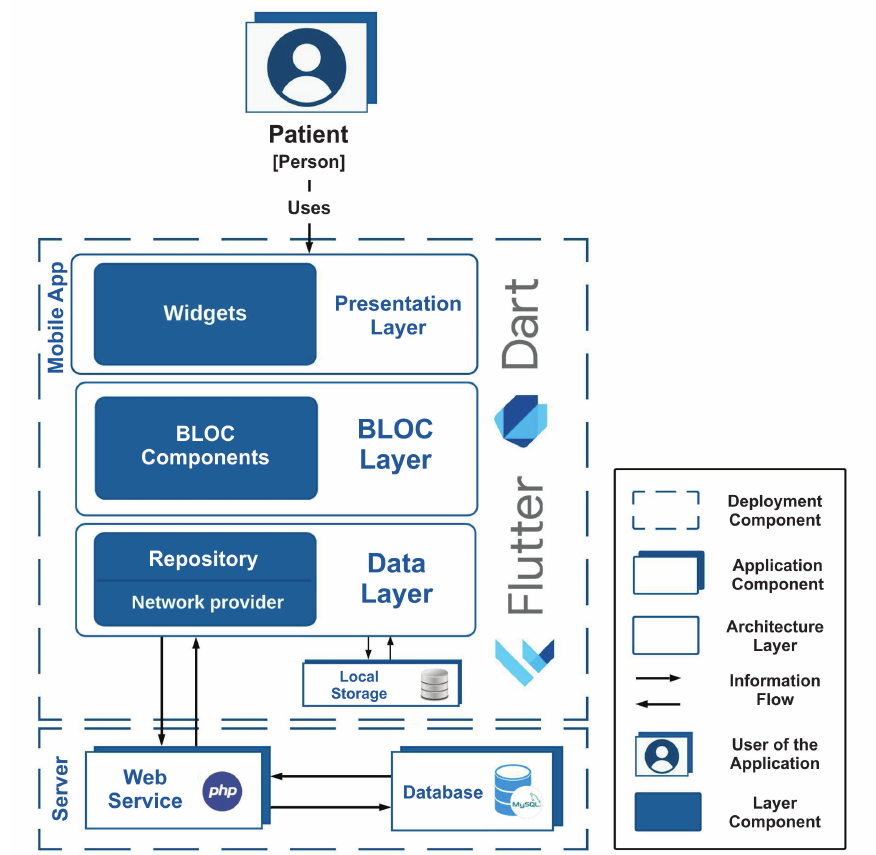
Figure 3. Static and physical view of the mobile